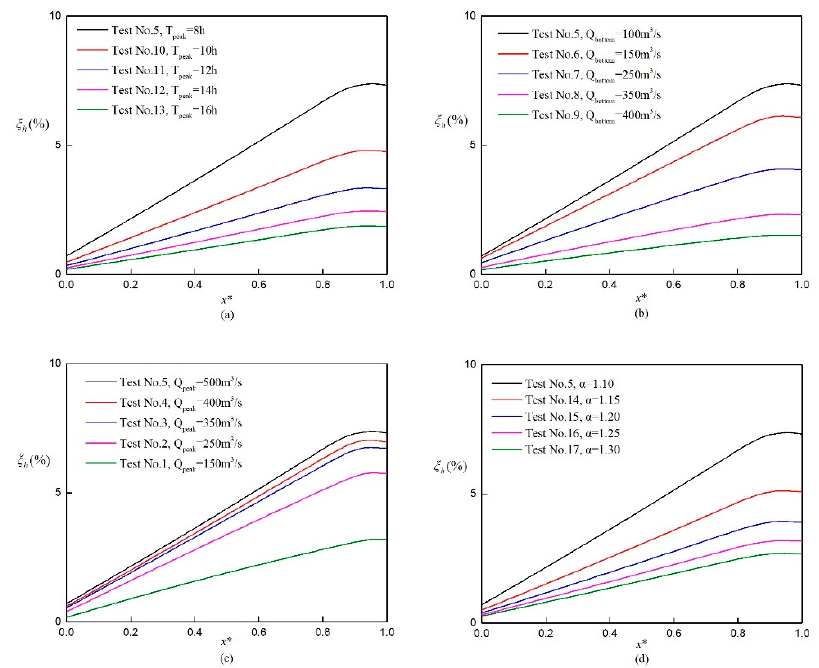
Figure 1. The influence of each parameter on the relative ξ h of kinematic wave approximation (KWA) along the channel. ( a ) T peak , ( b ) Q bottom , ( c ) Q peak , and ( d ) α